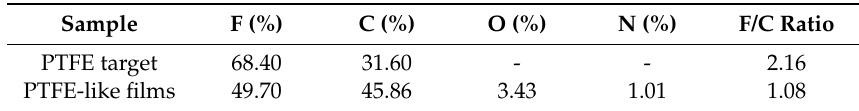
Table 1. Atomic composition of the investigated materials and F/C ratio of the conventional PTFE and sputtered PTFE-like films.